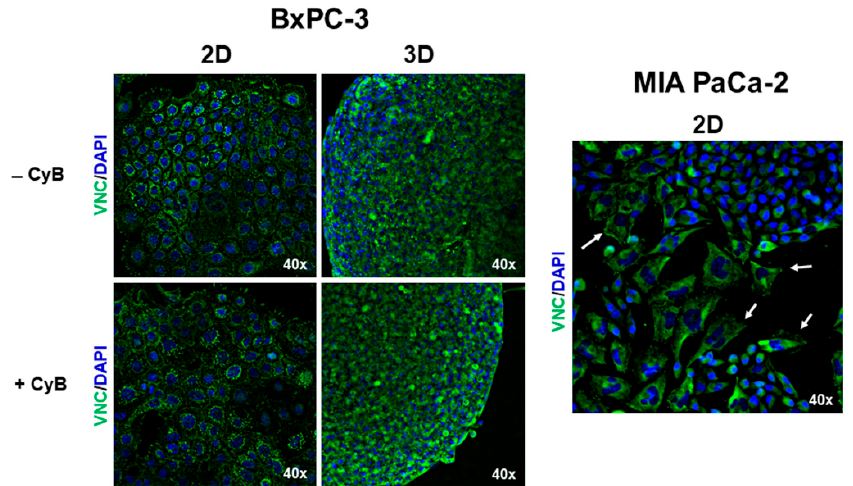
Figure 6. Immunofluorescence analysis for VNC (green) in BxPC-3 and MIA PaCa-2 cells. In BxPC-3 monolayers VNC is expresses at cell boundaries as well as in the cytoplasm revealing a punctate immunoreactivity. different than in 3D spheroids. In MIA PaCa-2 cells an evident VCN expression was detectable in fibroblastoid cells at the level of their lamellipodia (arrows). Original magnification: 40×. Since HAPAC, BxPC-3 and MIA PaCa-2 cells exhibit a different phenotype and